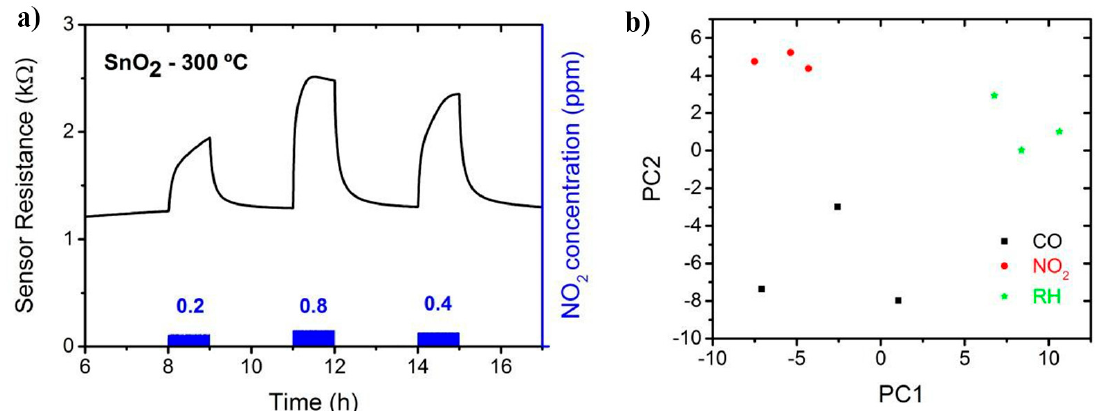
Figure 2. ( a ) Resistance evolution of a SnO 2 NW-based gas sensor device exposed to changing concentrations of CO diluted. in synthetic air at 300 °C; ( b ) Principal component analysis (PCA) for SnO 2 , WO 3 , and Ge NW-based gas sensor toward carbon monoxide, nitrogen dioxide, and relative humidity clearly showing the different clustering of the measured